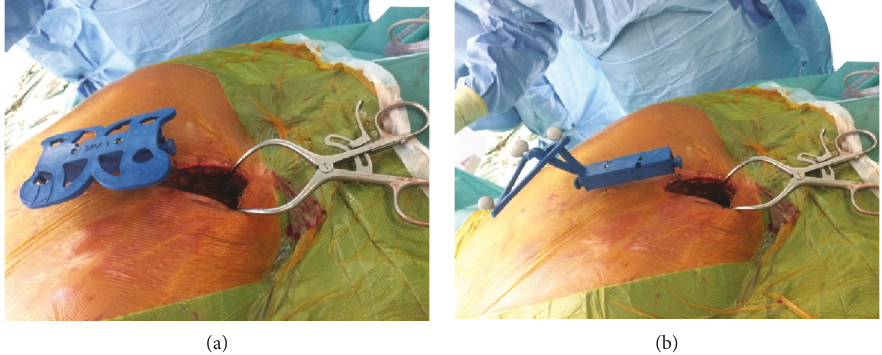
Figure 2: Patient reference in Surgivisio®. The reference frame is fi xed to the patient using 2 to 4 pins introduced into spinous processes. We can fi rst put an imaging reference frame (a), then another reference frame for the navigation (b).